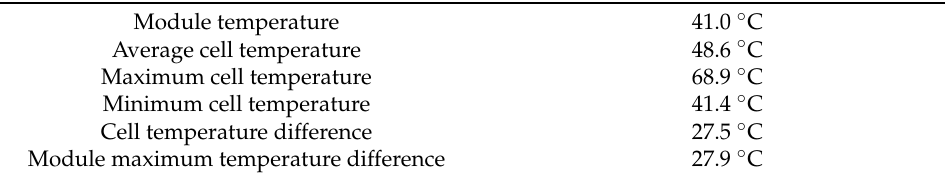
Table 6. Statistical data of the apparent temperature of the new module.